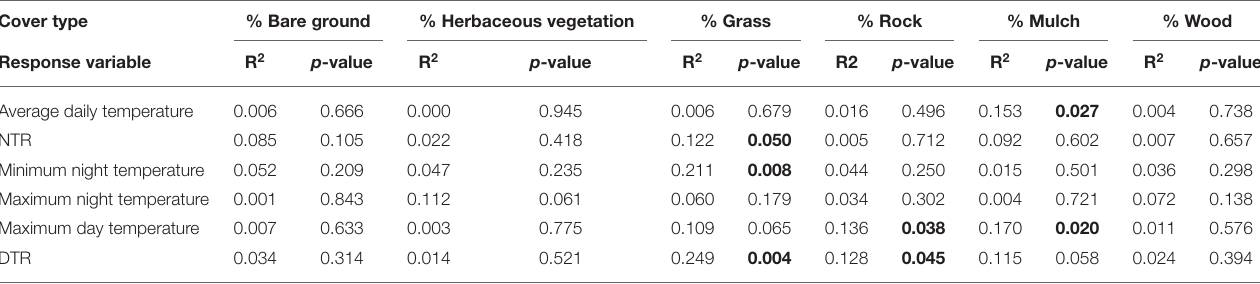
TABLE 2 | Relationships between the temperature parameters (response variables) and the local land use cover variables of the gardens (measured within 8 1 × 1-m plots). Cover type